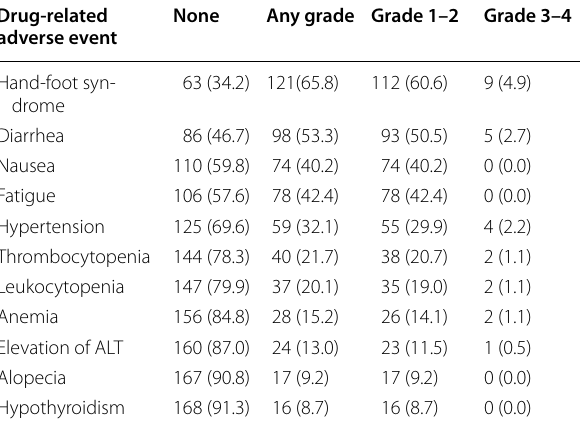
Table 7 Summary of drug-related adverse events in the 184 patients with metastatic renal cell carcinoma